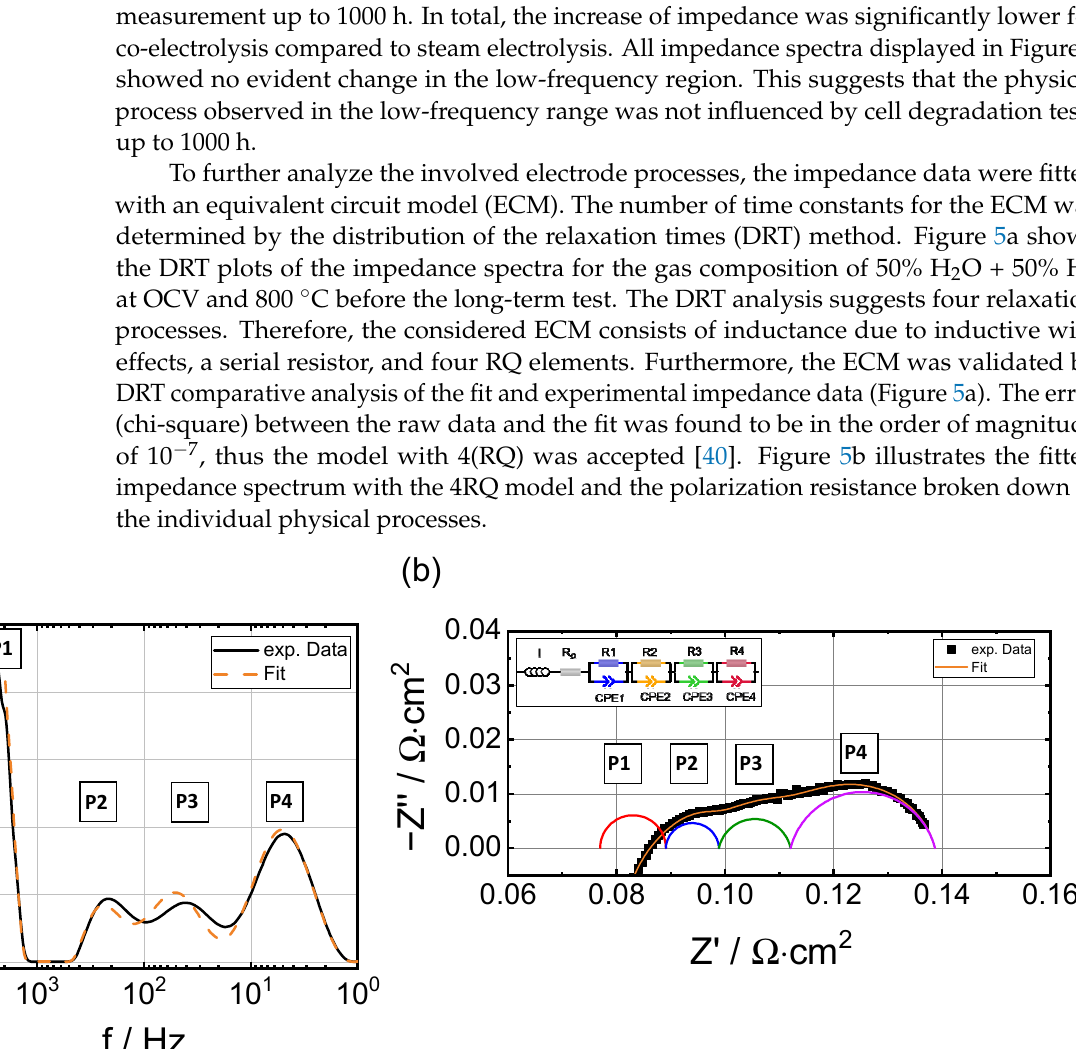
Table 2. Changes in ohmic and polarization resistance at the beginning and the end of durability testing.